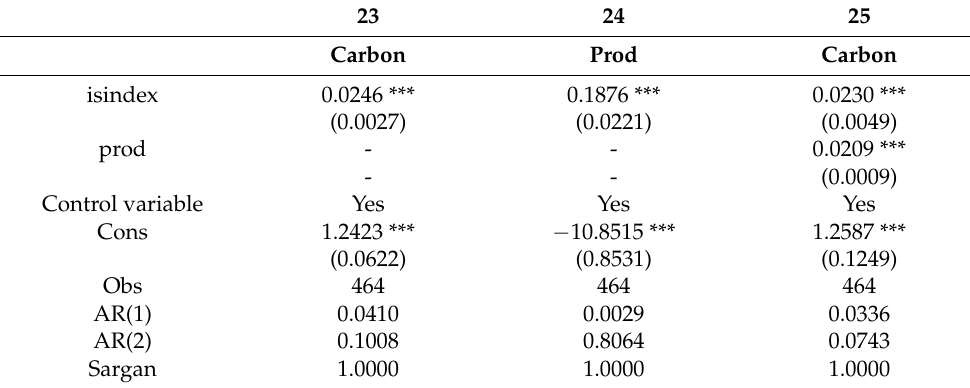
Table 6. Mediation effect of labor productivity.